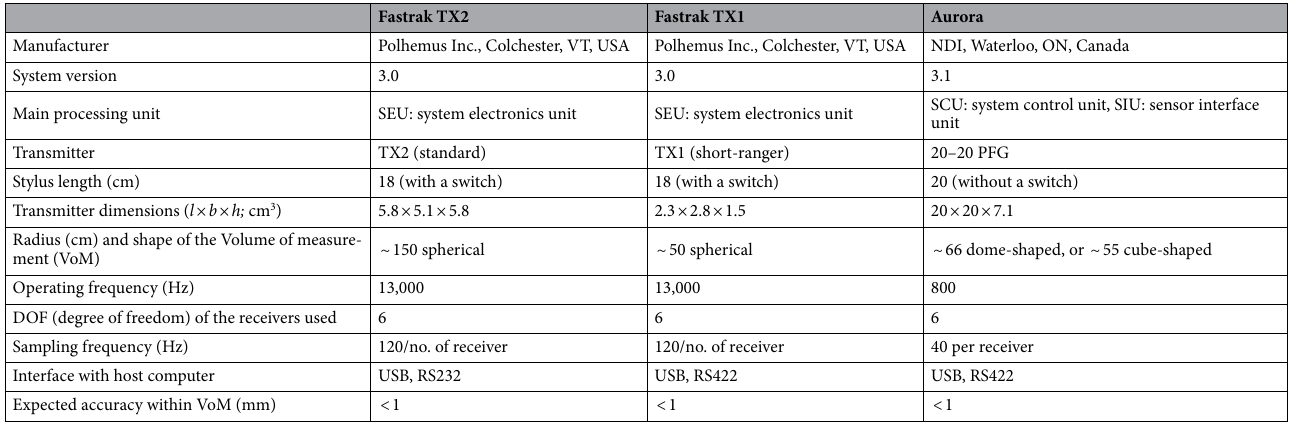
Table 1. Specifications of the systems used in the study.